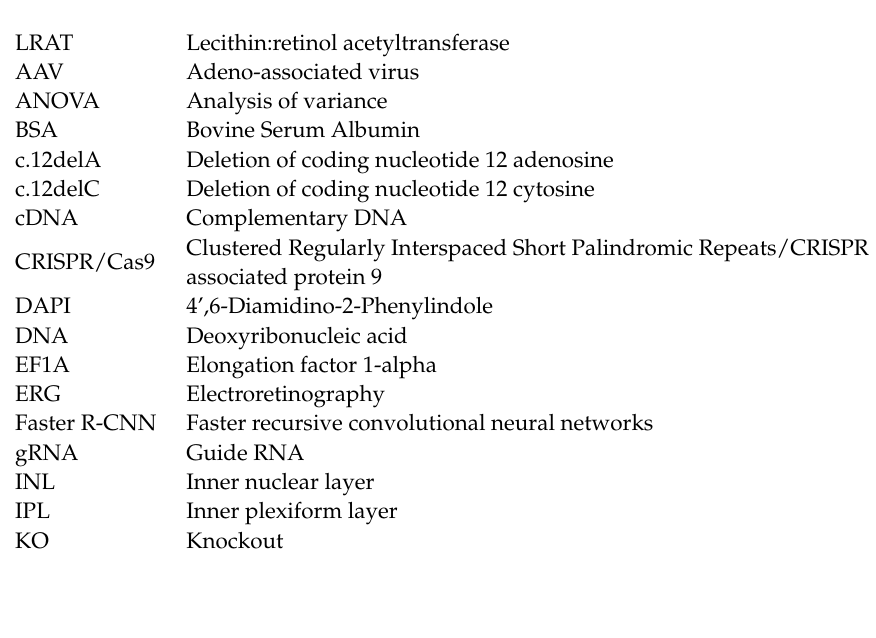
Figure S5: Scotopic ERG responses of single flash and flicker stimuli. Averaged traces (duration of 350 ms) ( n = 5 per group) with increasing flash intensities ( − 3.5–1.5 log(cd · s · m − 2 ) are plotted for Lrat +/+ (A) and Lrat +/ − animals (B) at the age of 23 weeks. Based on this data, no differences were observed between Lrat +/+ and Lrat +/ − animals. Supplementary File 1: The alignment of human and rat wildtype and knockout